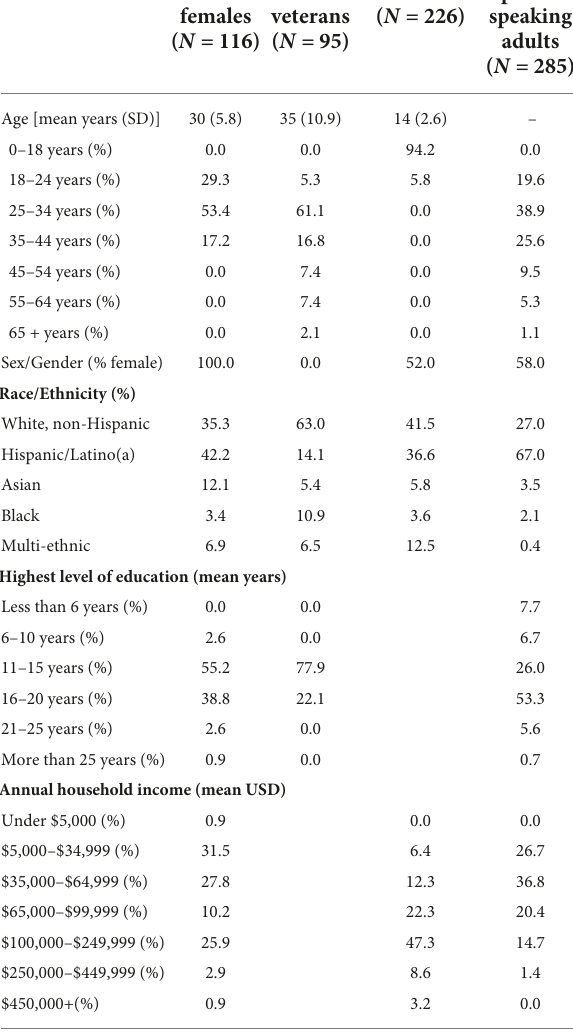
TABLE 2 Description of study